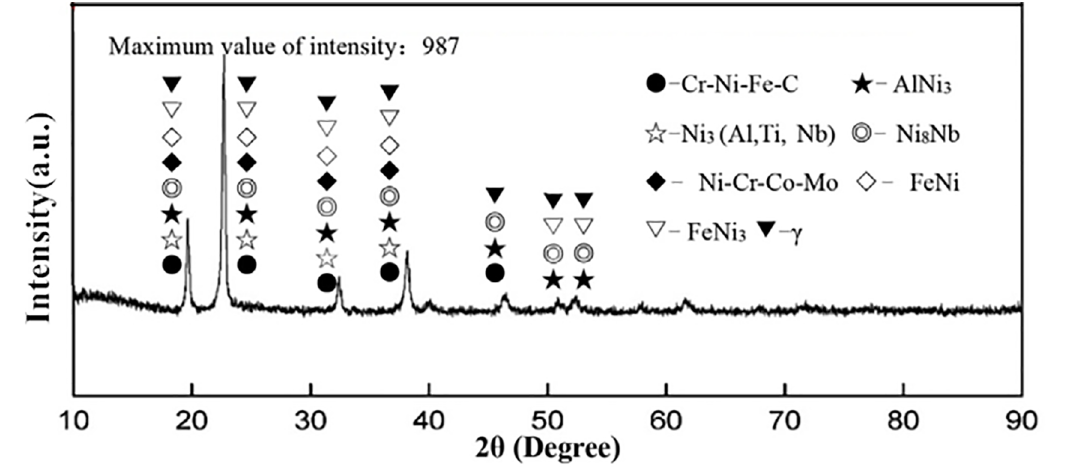
Figure 3. XRD curve of the base material before brazing